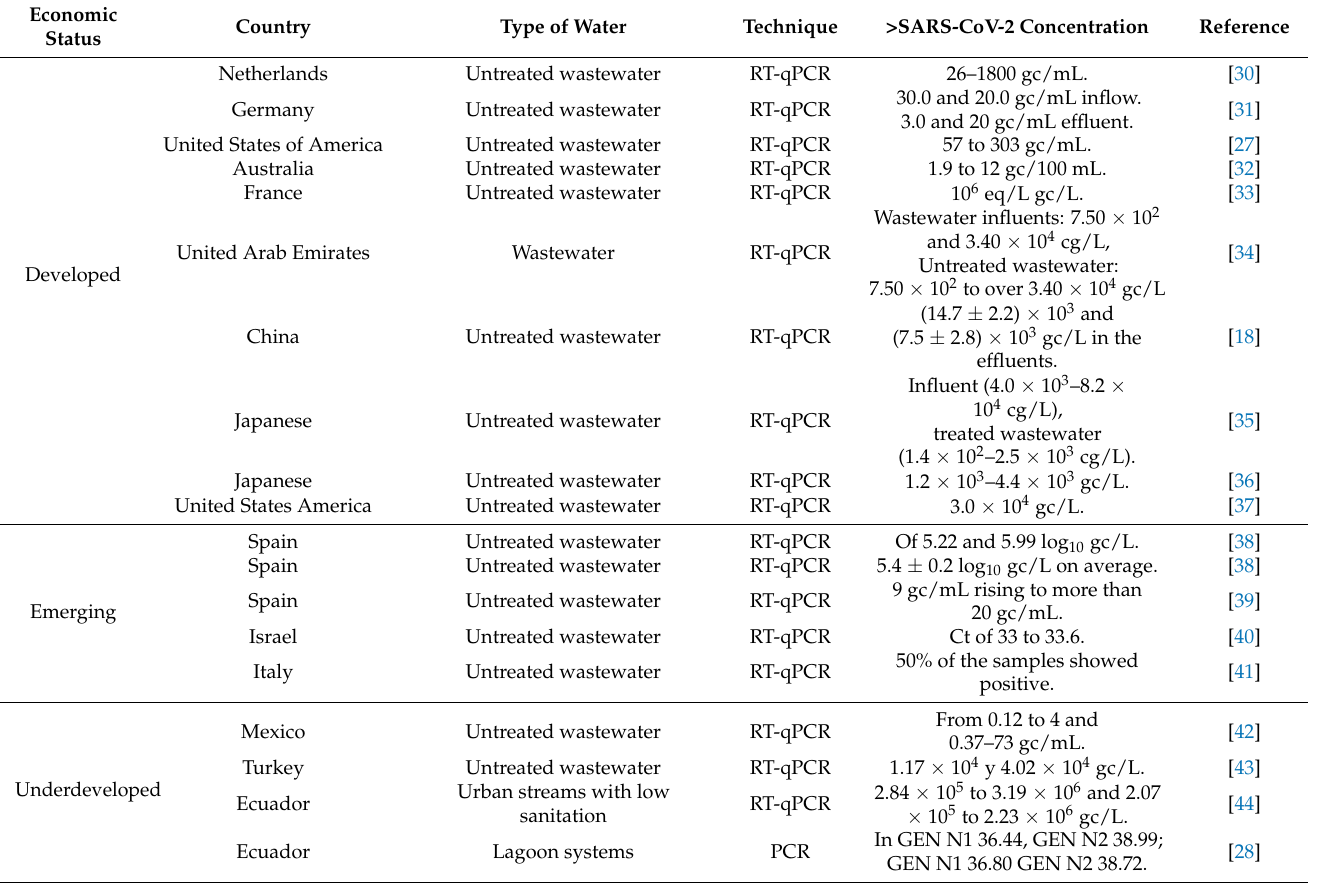
Table 1. Studies carried out in 14 countries and show that the virus is incorporated into wastewater.